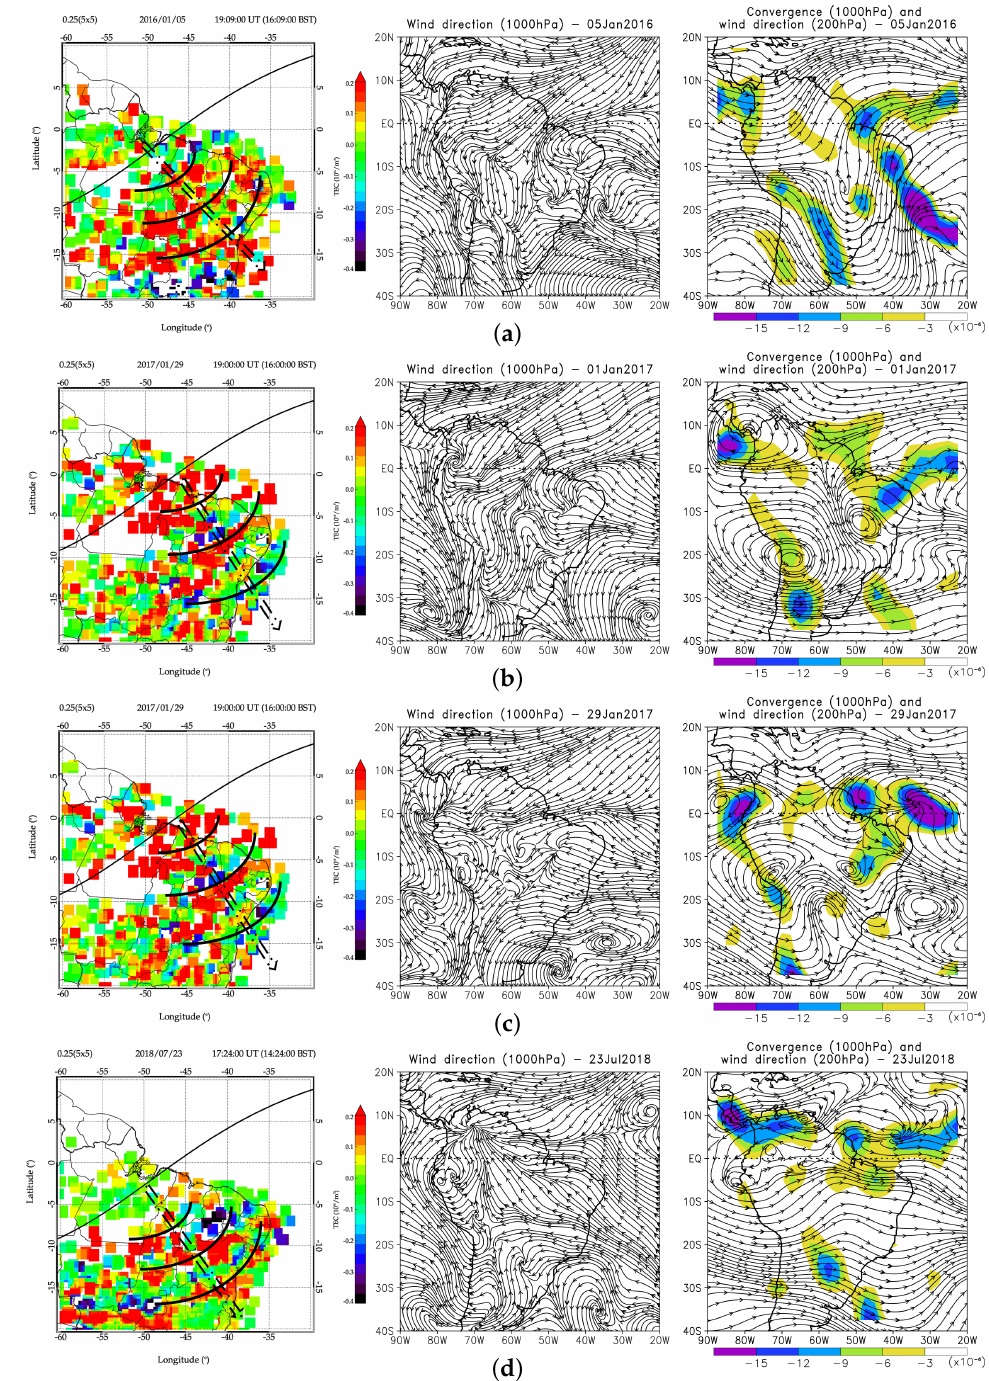
Figure 7. The ITCZ positions and the observed MSTIDs over South America on ( a ) 5 January 2016, ( b ) 1 January 2017, ( c ) 29 January 2017, and ( d ) 23 July 2018. In ( a – d ); the first column is the observed MSTIDs, with arcs showing the concentric nature of the waves, and the arrows showing the propagation direction; the second and third columns represent the ITCZ convergence (1000 hPa) and divergence (200 hPa) positions using reanalysis